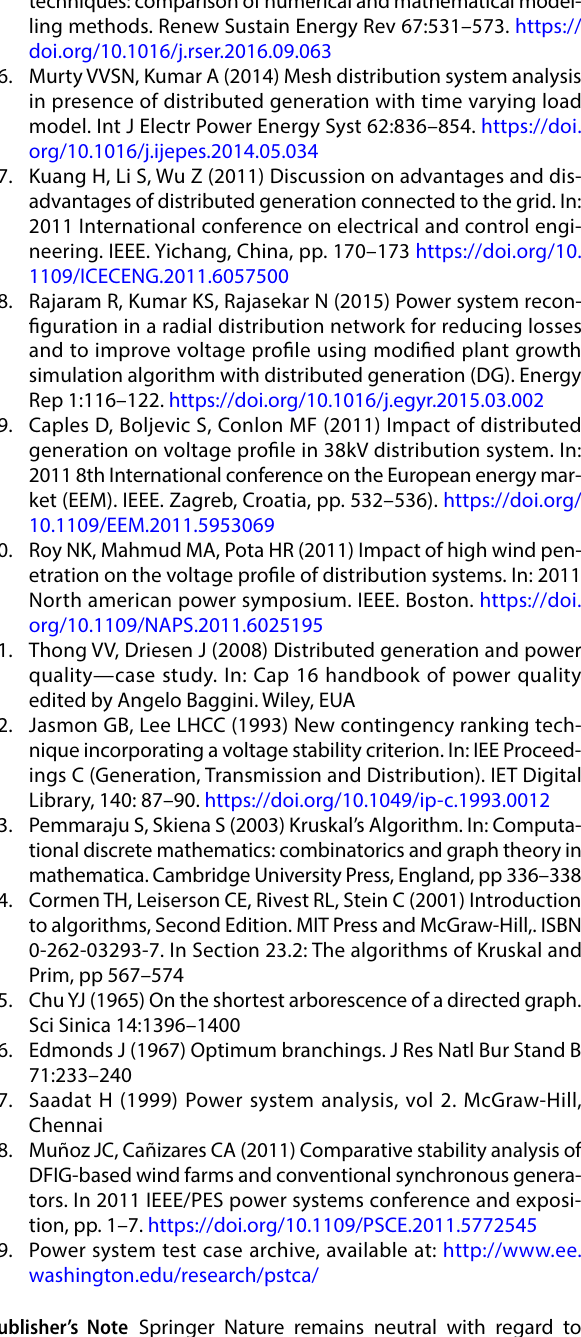
figuration for loss reduction and load balancing using plant growth simulation algorithm. Int J Electr Eng Inform. https://